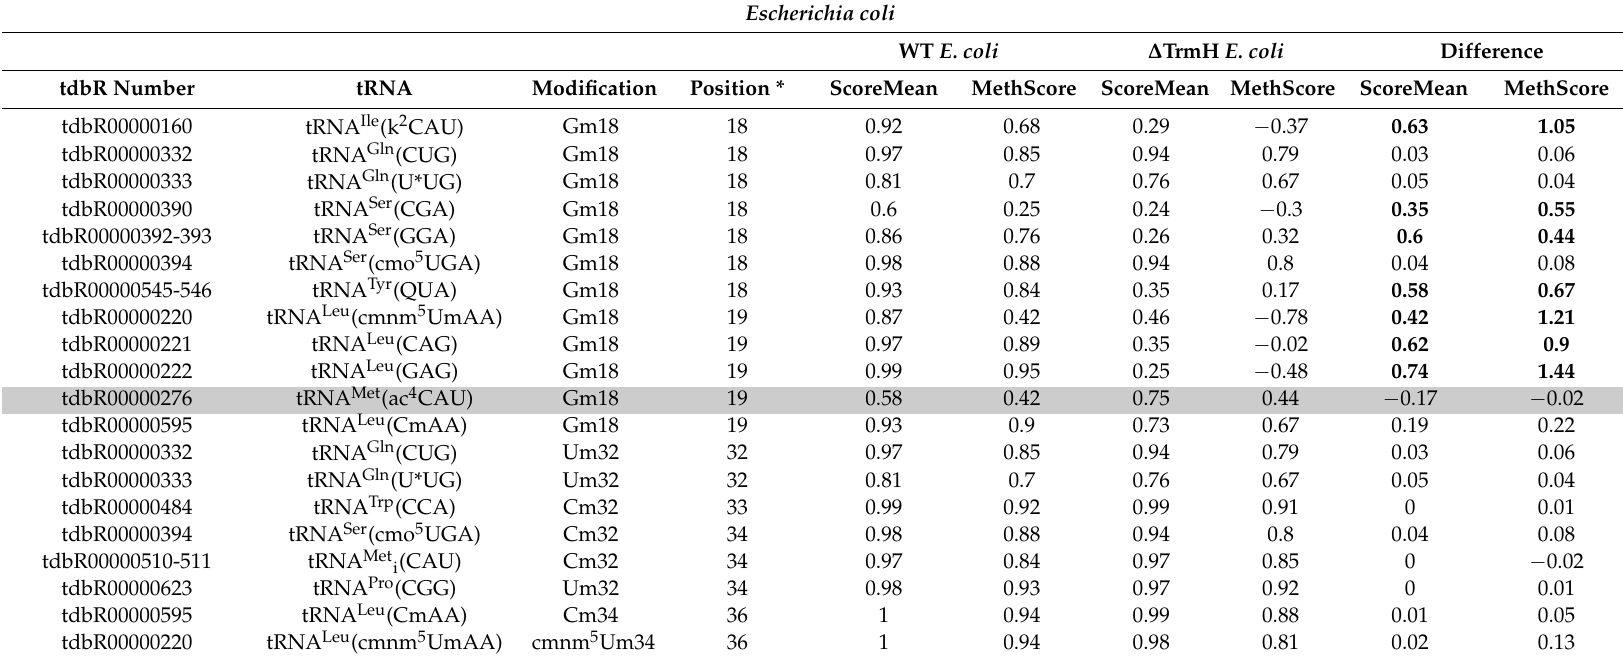
Table 2. Calculated ScoreMean and MethScore for known 2 (cid:48) - O -methylated positions in E. coli and S. cerevisiae tRNAs extracted from WT and the strain lacking tRNA:Gm18-MTase (TrmH or